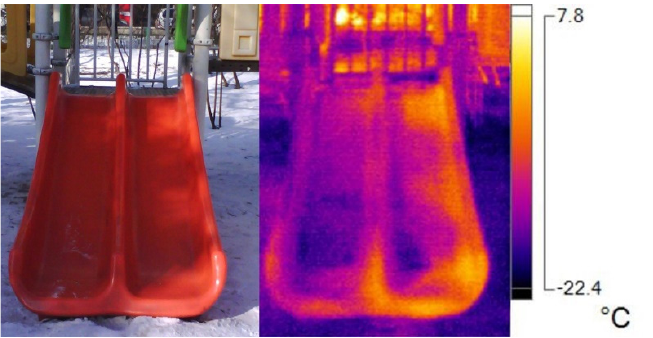
Figure 4. Infrared thermal image captured in space SP (photographed by the author on 17 January